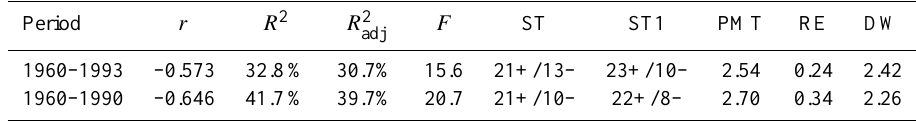
Table 1. Calibration and verification statistics for the regression model. Period r R 2 R 2